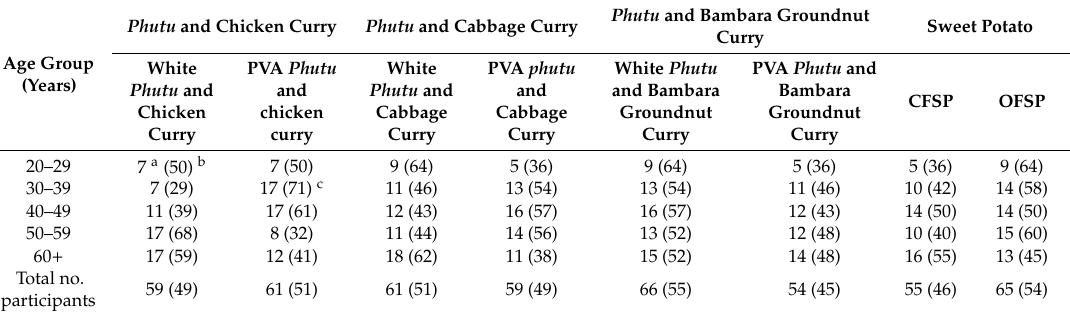
Table 11. Preference across age groups ( n = 120).